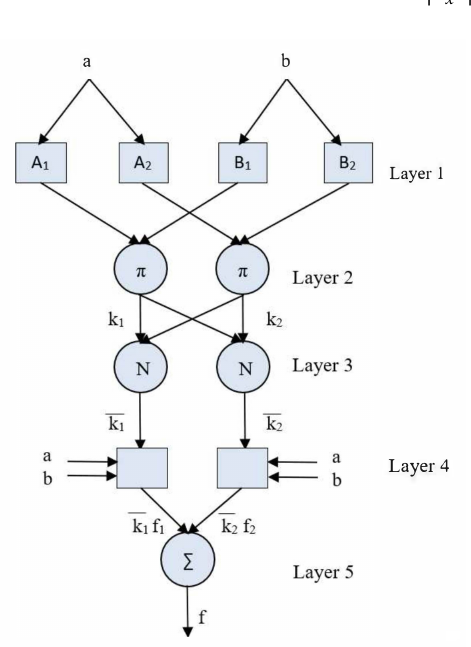
Figure 3. Structure of the adaptive neuro-fuzzy inference system